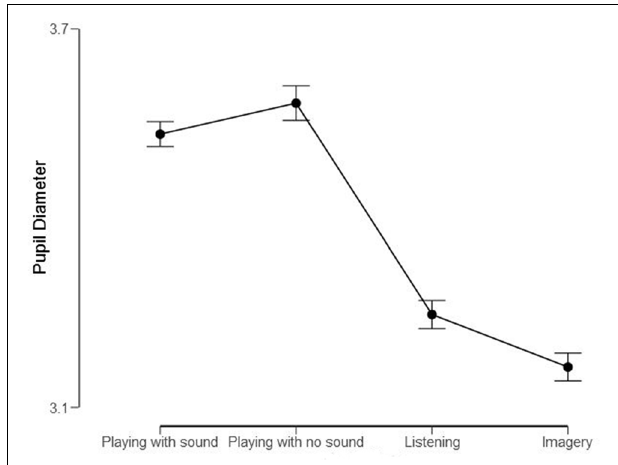
FIGURE 4 | Mean pupil diameters (in mm) of the Professional Pianist for the four conditions. Bars represent 95% confidence intervals.